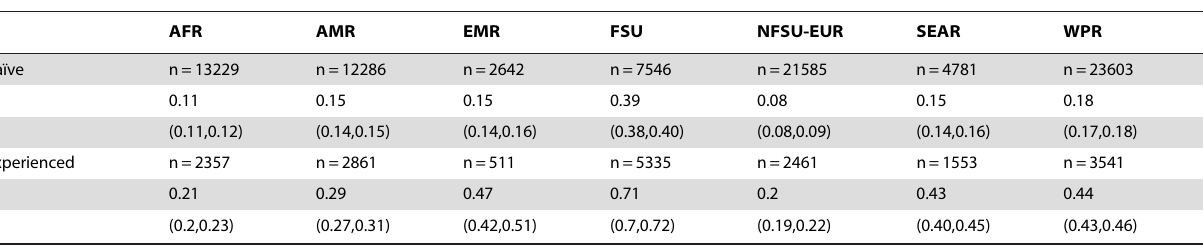
Table 1. Breakdown of data by region.